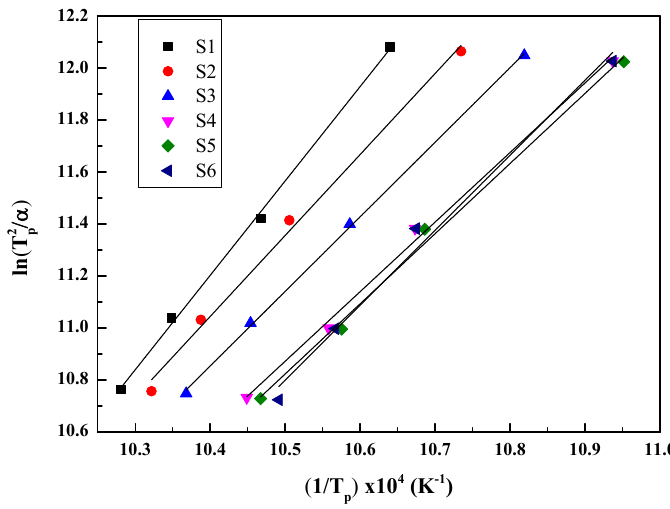
Figure 5. Variation of ln T 2 p / α versus 1/ T p for glass specimens.